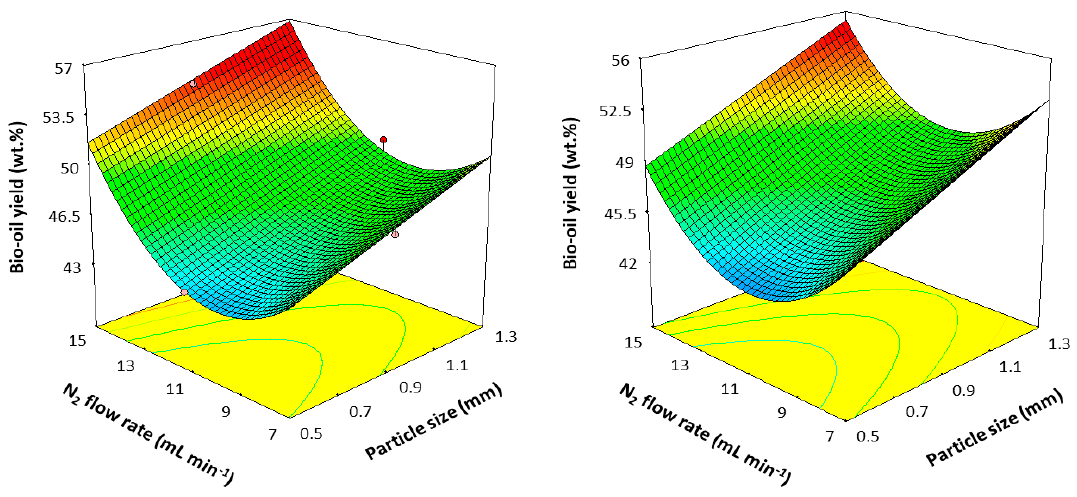
Figure 4. Response surface plots showing the effects of particle size and N 2 flow rate on the bio-oil yield from the pyrolysis of pigeon pea wood at a fixed temperature of 400 °C (left) and 466 °C (right).